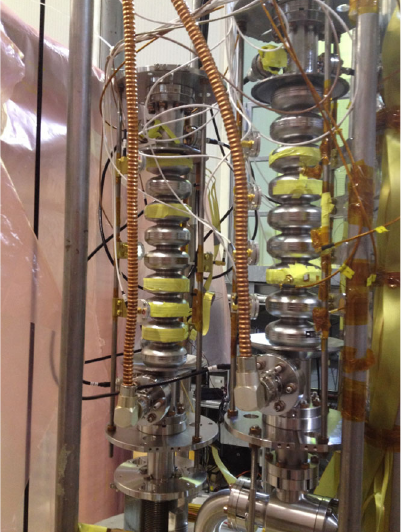
FIG. 9. Vertical insert with two cavities ready for vertical test, fully equipped with thermometers and second sound